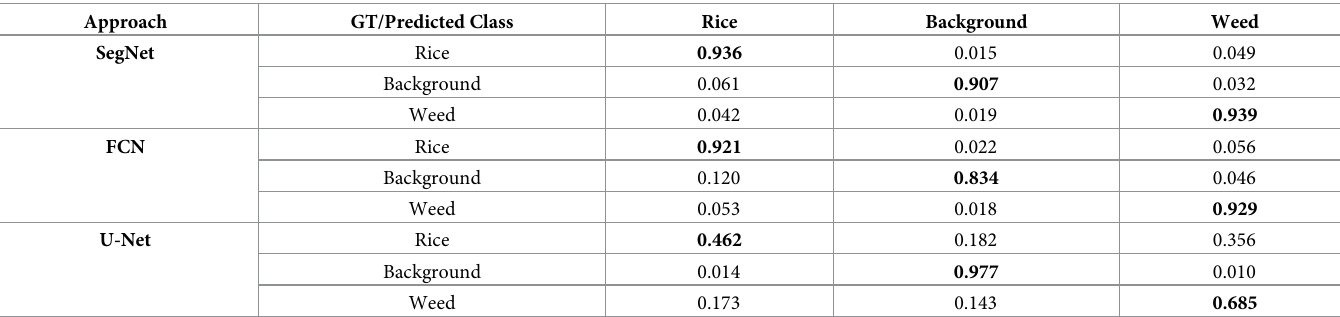
Table 4. Comparison of the SegNet, FCN and U-Net approaches.